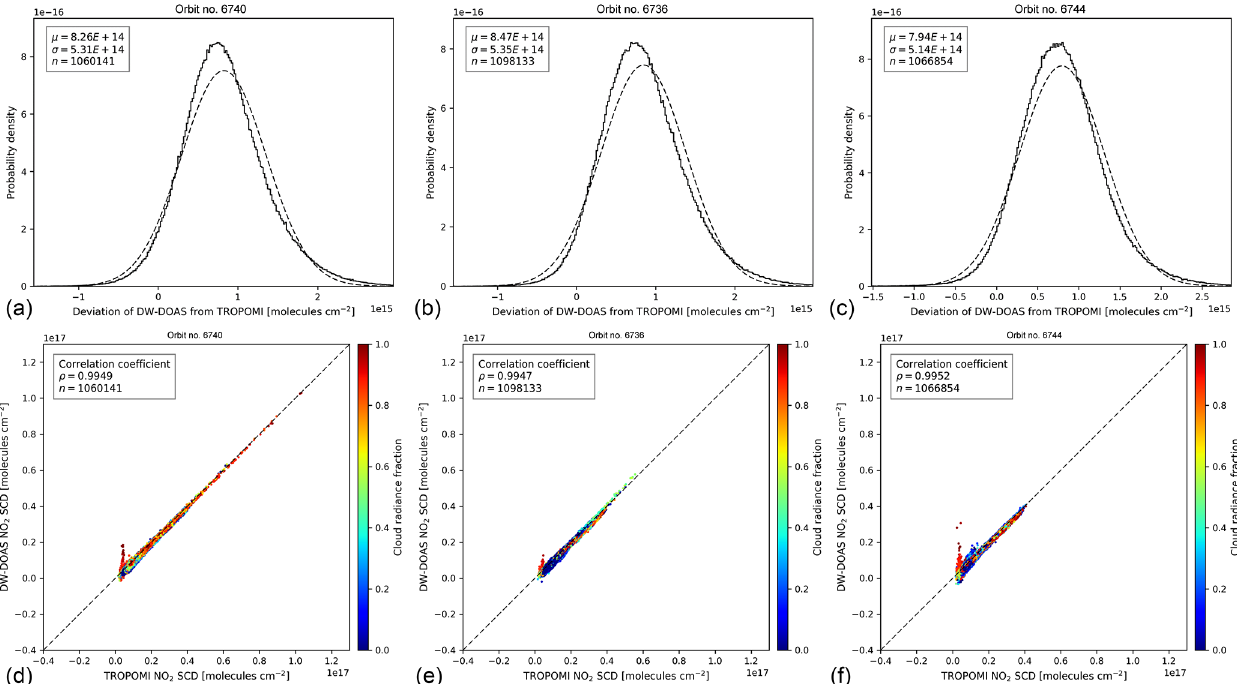
Figure 8. (a, b, c) Distribution of absolute differences between the NO 2 SCDs retrieved by DW-DOAS and TROPOMI for the orbits in Fig. 7, calculated as (TROPOMI – DW-DOAS), and (d, e, f) corresponding correlation plot.